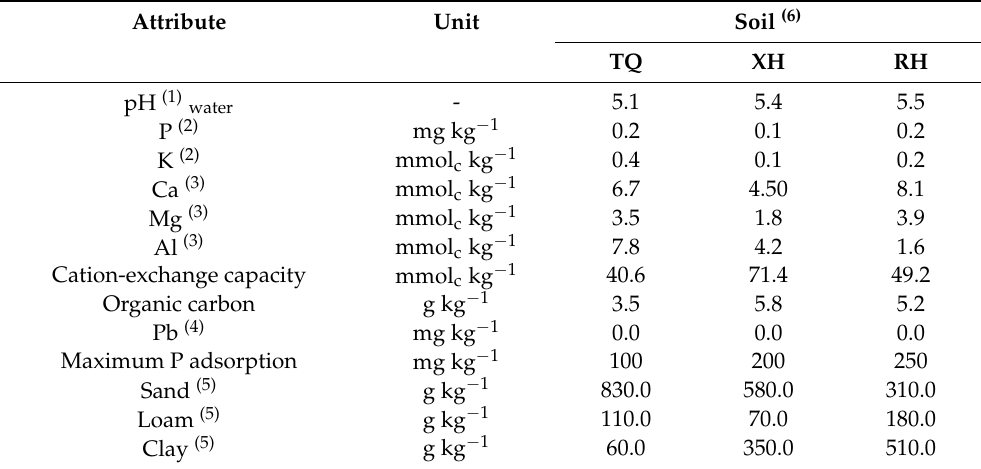
Table 1. Soil attributes before application of basic fertilizer and Pb